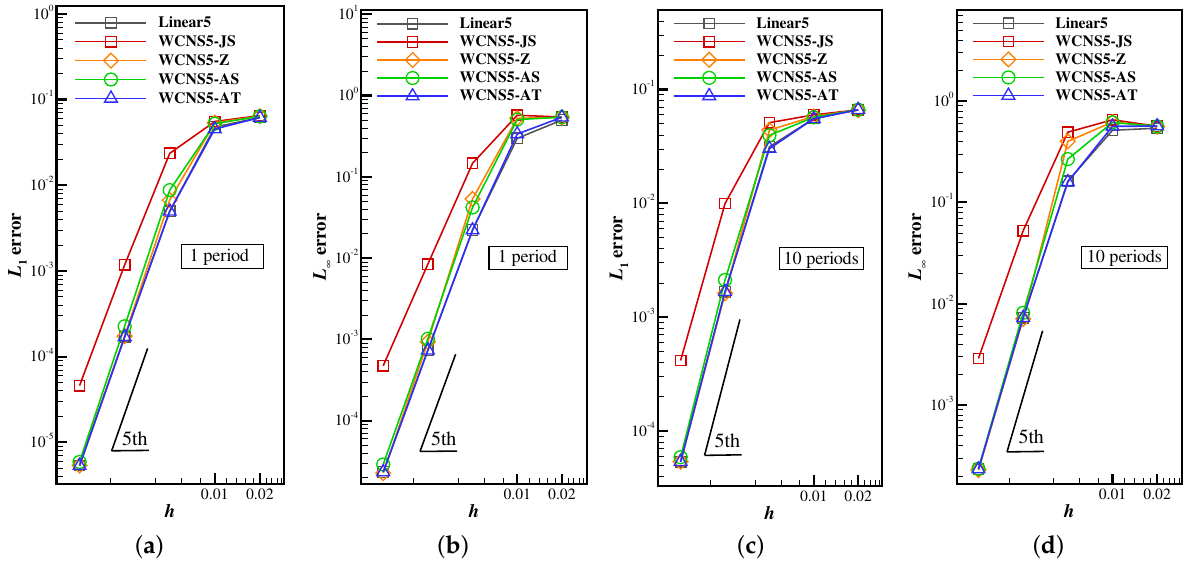
∑ 20 sin ( 2 π kx ) : ( a ) L 1 error, 1 period; ( b ) L ∞ error, 1 period; k = 1 20